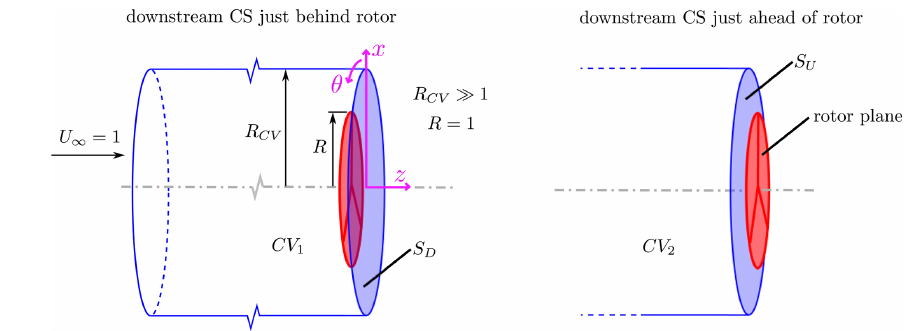
Figure 1. Control volumes (CVs) for the present analysis. In both variants, the upstream face is well upstream of the rotor, where the velocity is equal to the freestream, and R CV (cid:29) R . The downstream control surface is just downstream and just upstream of the rotor plane in CV 1 and CV 2 , respectively, and the corresponding downstream control surfaces (CSs) are labelled S D and S U .